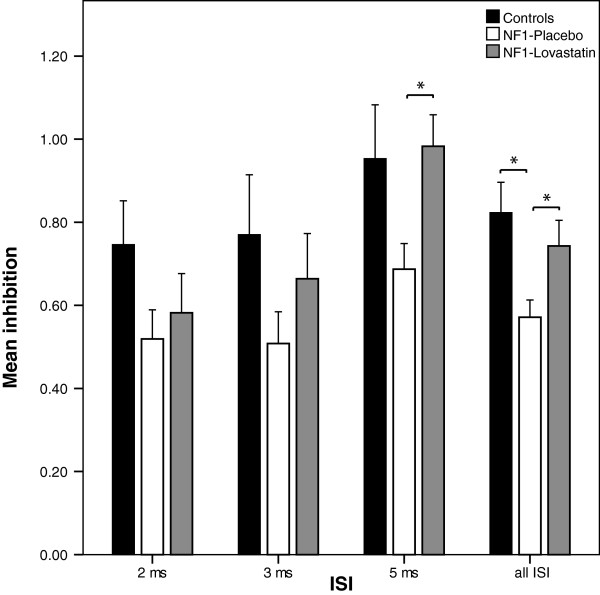
SICI in healthy controls and patients with NF1 in on/off medication. Depicted are data of 10 patients of NF1 and healthy controls in on/off medication. Mean inhibition at 60% resting motor threshold (for more details see methods) of the conditioning stimulus was built for ISI of 2, 3, 5 ms and over all ISI. Here, a trend towards increased inhibition in patients with NF1 (treated with placebo but not with lovastatin) compared to healthy controls can be observed. Error bars represent ± standard error of the mean.